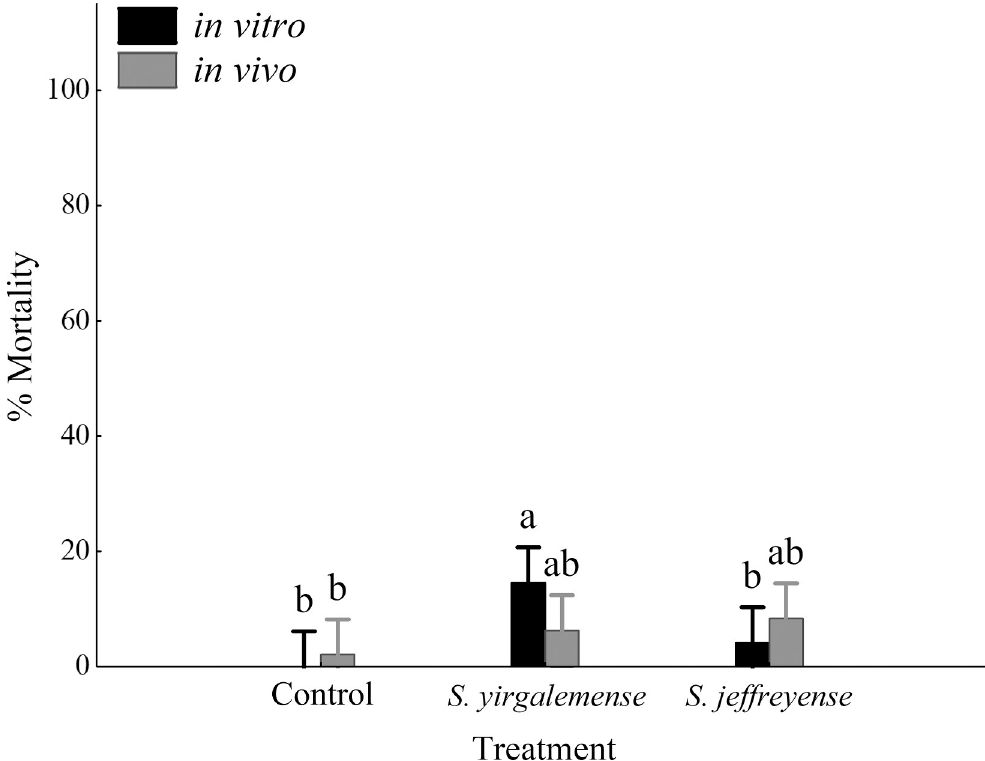
Fig 2. Percentage mortality of Lobesia vanillana pupae, 48 h after treatment. Percentage mortality (95% confidence intervals) of Lobesia vanillana pupae, 48 h after inoculation with in vitro- and in vivo -cultured infective juveniles (IJ) of Steinernema yirgalemense and S . jeffreyense , at a concentration of 200 IJs/50 μ l. Vertical bars were calculated using least square means. Different letters on the bars denote statistical significance, calculated using Games-Howell (MSE = .00736; df = 42; p < 0.05).